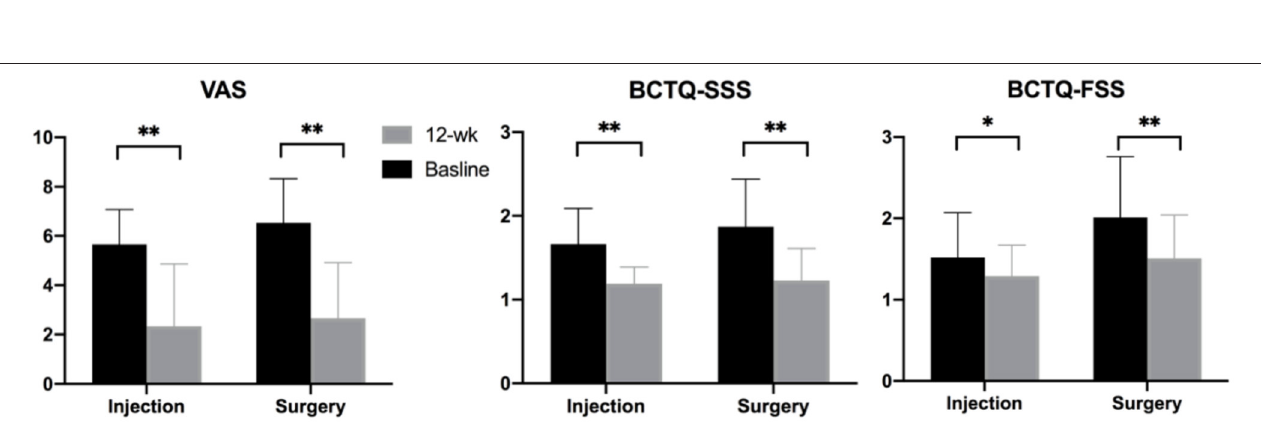
FIGURE 4 | Clinical outcomes measured at baseline and 12-week follow-up. Note: * p < 0.05, ** p < 0.001. BCTQ, Boston carpal tunnel questionnaire; FSS, functional status scale; SSS, symptom severity scale; VAS, visual analog